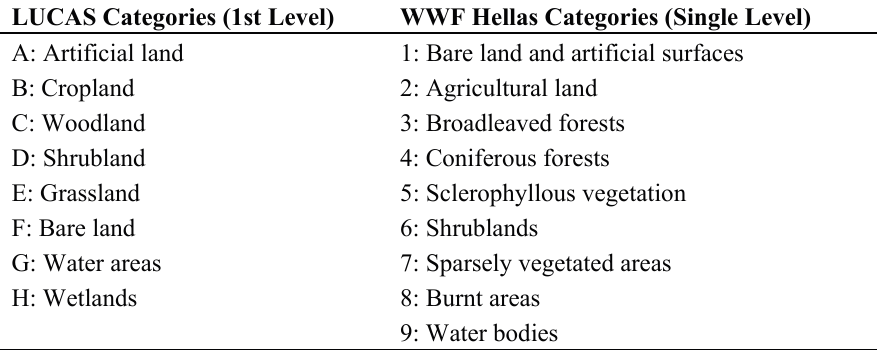
Table 1. A summary of codes and names for the first level of LUCAS and for the single level of the WWF Hellas